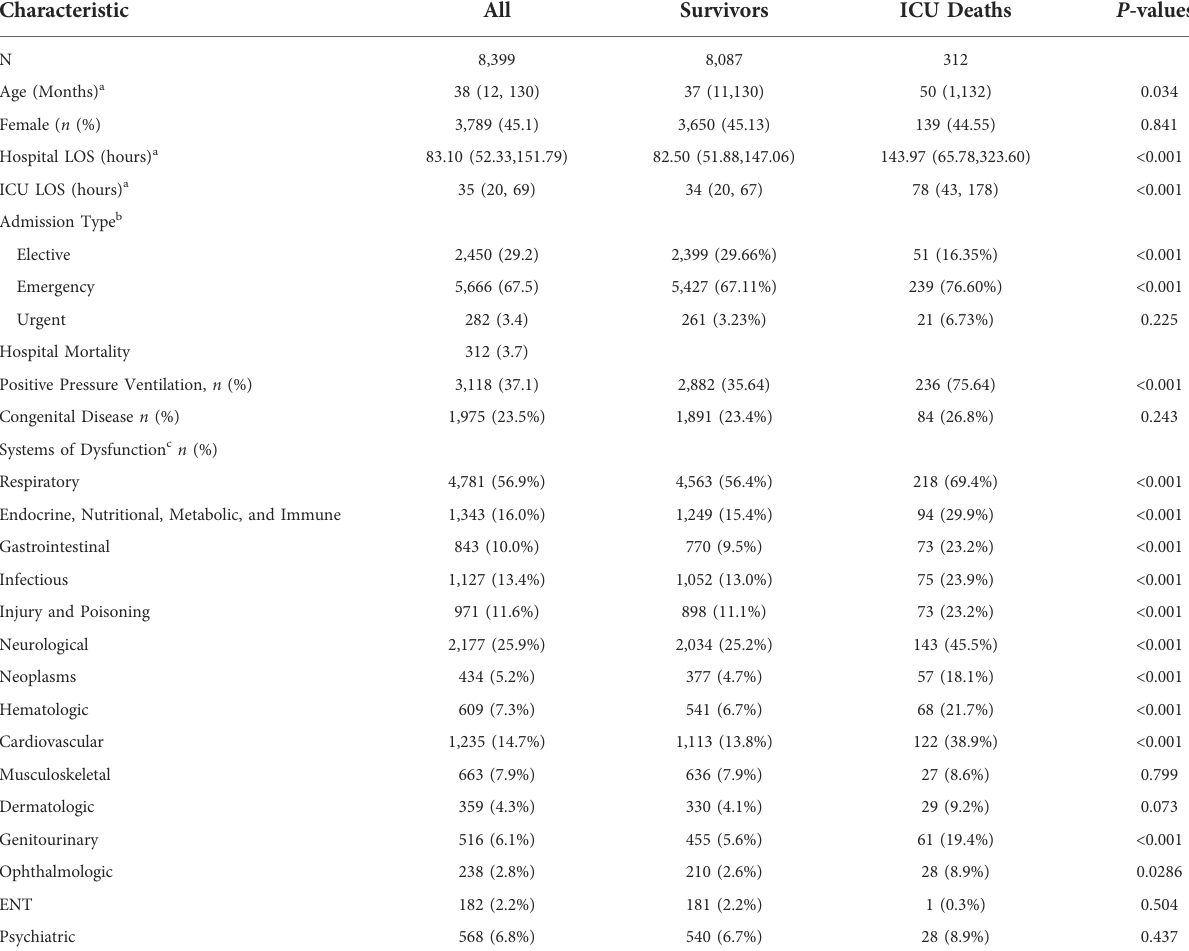
TABLE 1 Population characteristics the mann whitney U test was used to compare the distribution of numerical quantities between survivors and deaths. The Santner and Snell exact test was used to compare proportions (percentages) between survivors and deaths. A single encounter could have diagnoses in multiple